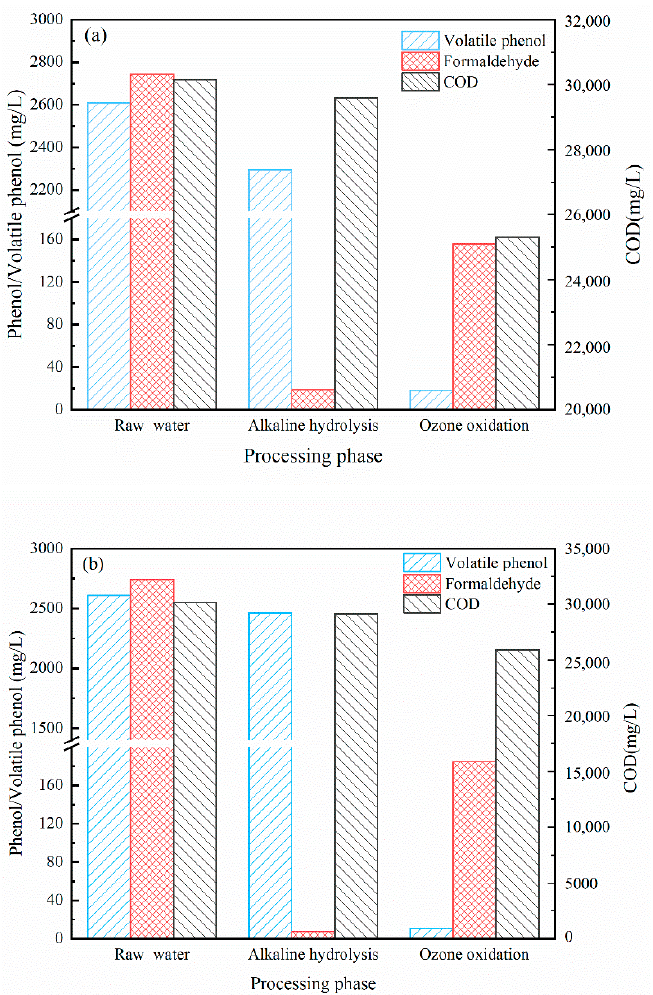
Figure 2. Effects of synergistic ozone catalytic oxidation with different alkaline hydrolysates on the removal of volatile phenols and formaldehyde: ( a ) Ca(OH) 2 and ( b ) NaOH.